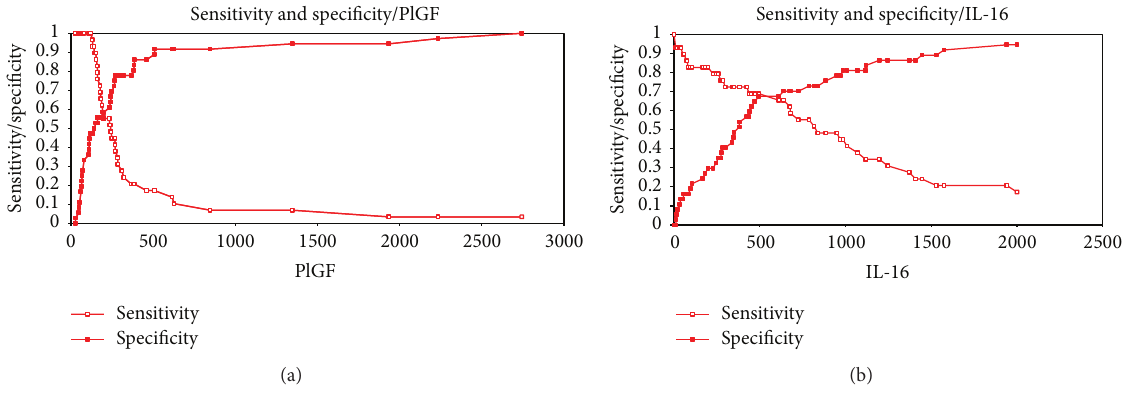
Figure 3: (a) Sensitivity and specificity of PlGF. (b) Sensitivity and specificity of IL-16.